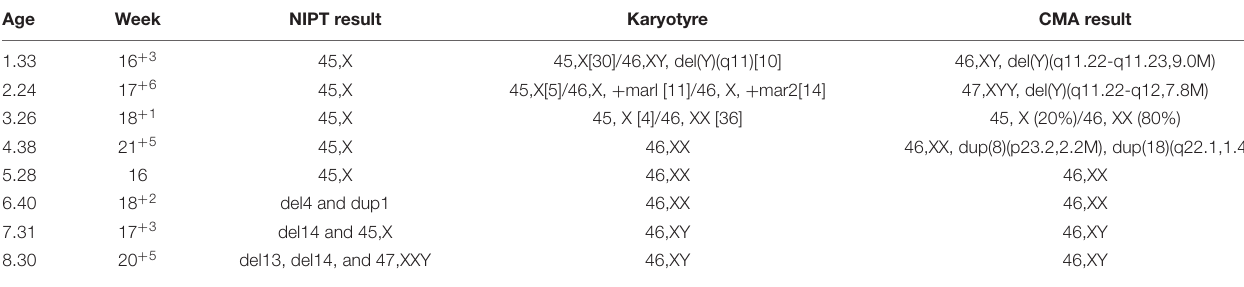
TABLE 3 | Karyotype and CMA verification of eight NIPT positive